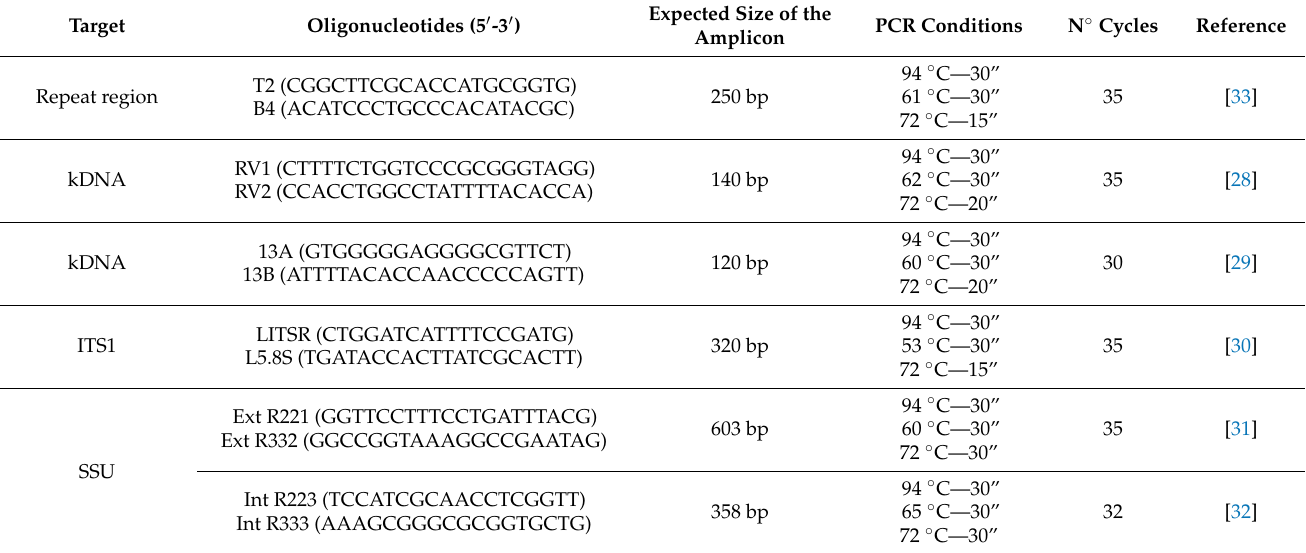
Table 1. PCR targets and primer pairs and conditions employed in each PCR